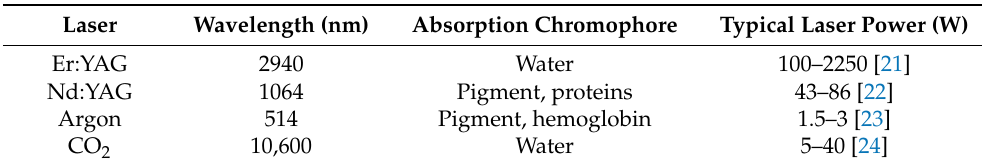
Table 1. The conventional lasers commonly used in bone-related procedures, with operation wave- lengths and absorption chromophores